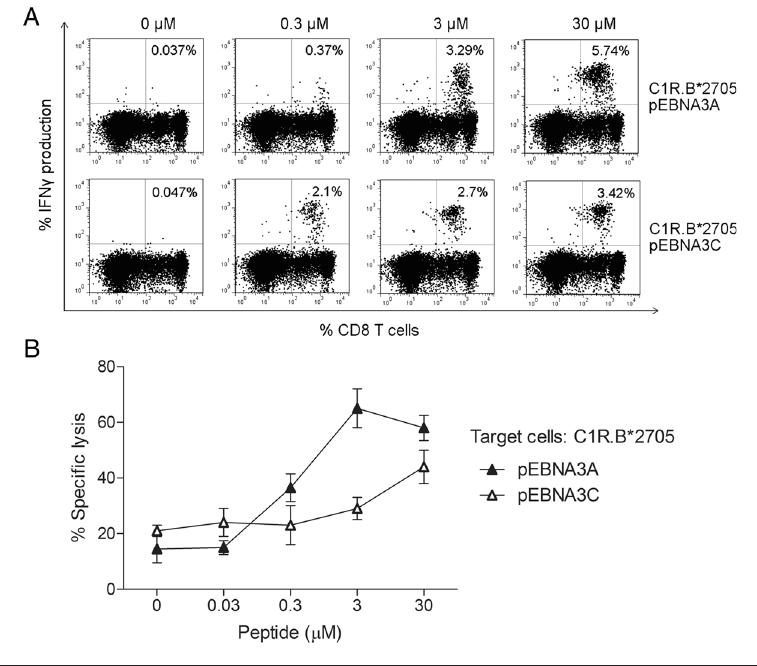
Figure 4. Functional avidity compared between pEBNA3A- and pEBNA3C-specific CD8 + T cells from B*2705 donors. (A) Flow cytometry plots reporting IFN γ production by PBMCs from a representative B*2705 AS patient (Don 15.05) expanded in presence of pEBNA3A or pEBNA3C (14 d) and exposed to C1R.B*2705 transfectants pulsed with increasing concentrations of each peptide before intracellular staining. Numbers indicate the percentage of IFN γ -secreting CD8 + T cells. (B) Assessment of the cytolytic activity of rep- resentative pEBNA3A- and pEBNA3C-stimulated CTL lines from the same donor as in (A). C1R.B*2705 transfectants pre-pulsed with serial amounts of the indicated peptide were used as targets. E/T ratio was 20:1. Bars represent the mean percentage of specific lysis ± SEM of three separate